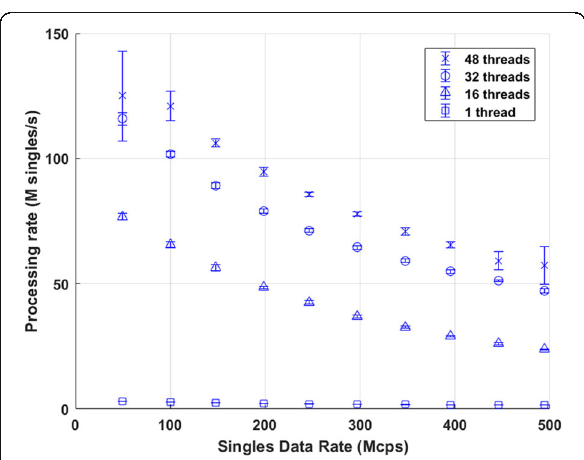
Fig. 1 (abstract A12). Performance of the coincidence processor. The error bar represents the standard deviation of 10 individual runs